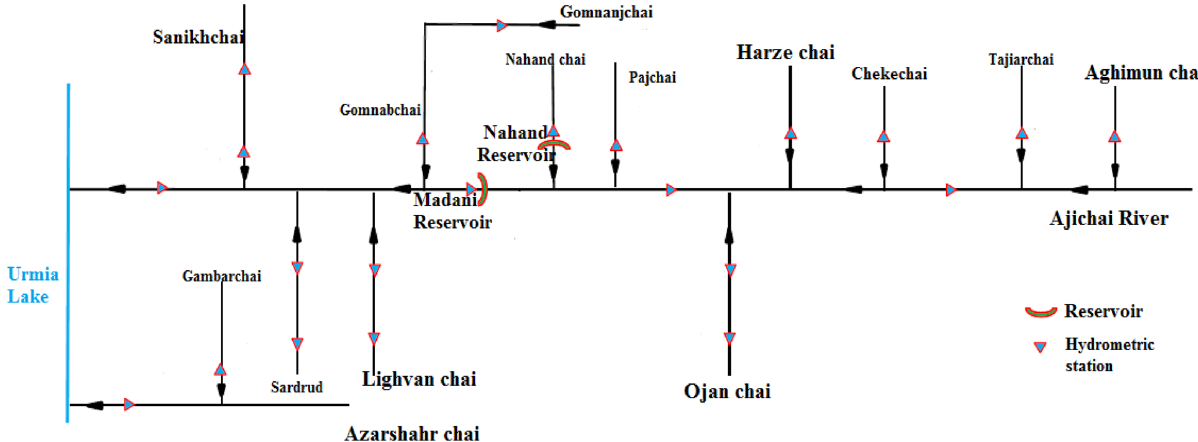
Figure 2. Rivers and their connections to Urmia Lake and the hydrometric